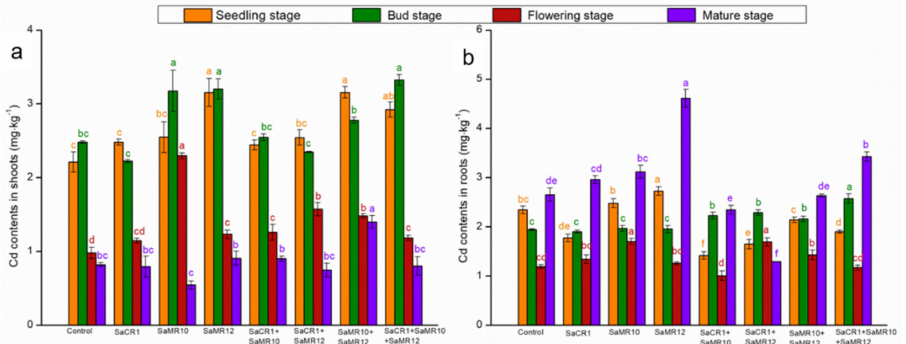
Figure 5. Effects of PGPB inoculants on Cd contents in ( a ) shoots and ( b ) roots of B. juncea at different growth stages. Orange, green, red, and purple represent the seedling stage, bud stage, flowering stage, and mature stage, respectively. The letters of corresponding colors indicate the significant differences among different treatments at the same growth